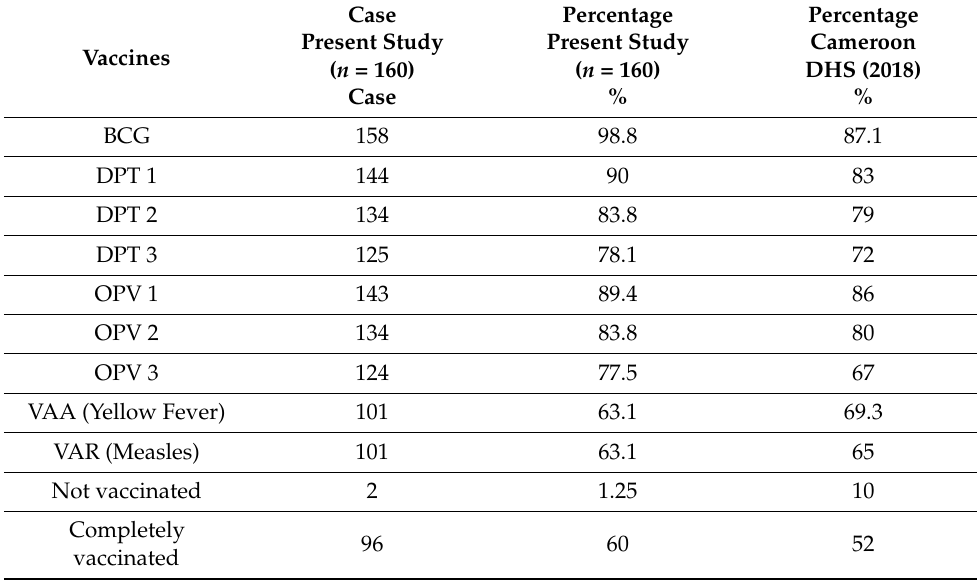
Cameroon from the Sociodemographic Health Survey (DHS) in 2018. Case Percentage Percentage Present Study Present Vaccines